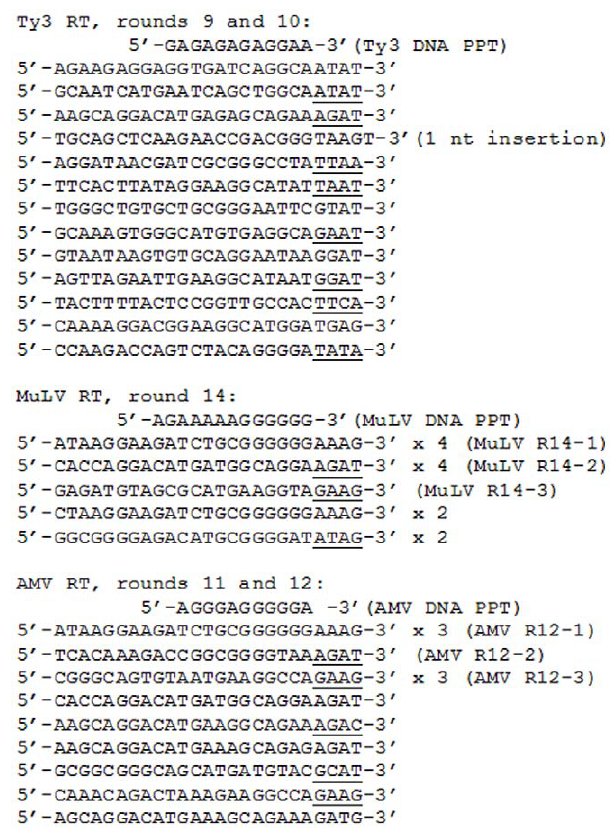
Figure 3. Sequences recovered from SELEX experiments. The nucleotide sequence of material recovered with the indicated enzyme in the indicated round(s) of the primer-template SELEX protocol are shown. Only the sequence in the 25 nt randomized region of the primer strand is shown. The sequence of a DNA version of the PPT for each RT is shown at the top of each set of recovered sequences for reference. During selection, the primer strand was only 21 nts long, the last four nts at the 3 9 end of each sequence are underlined since they were not present on the primer during selection. However, complementary nts were present on the template strand. Specific sequences recovered with MuLV and AMV and used to prepare constructs for K d determinations are designated with names corresponding to those in Fig. 1. Sequences recovered more than once are indicated by an ‘‘X’’